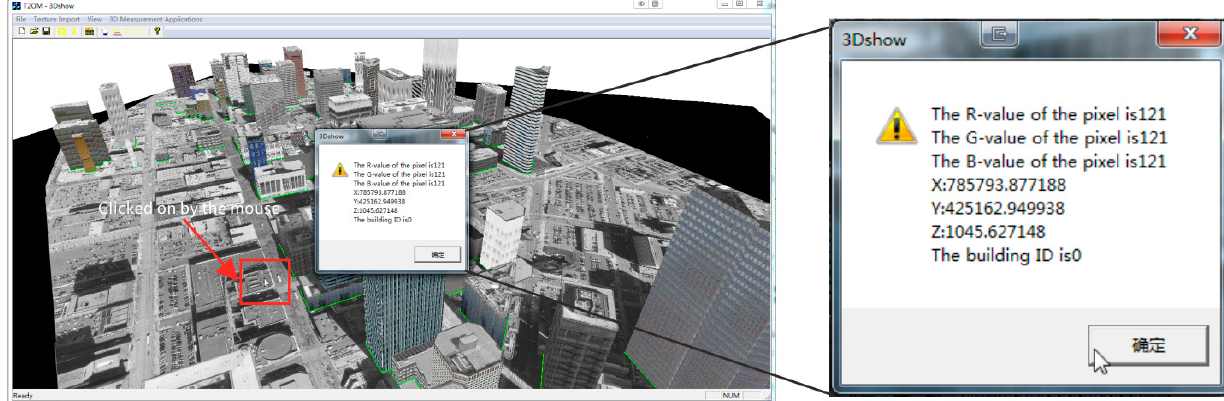
Figure 21. Measuring the elevation of any point on the façade.